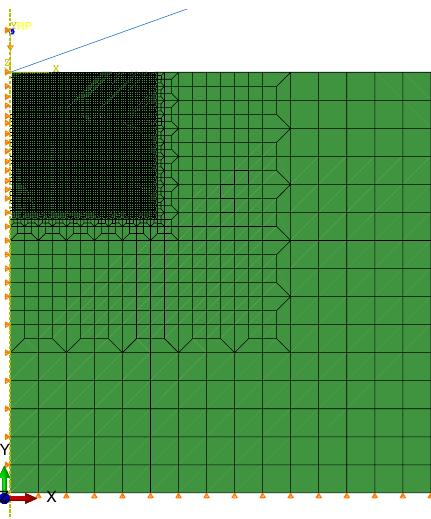
Figure 12. Mesh and Boundary Condition of Instrumented Indentation Simulation Model.